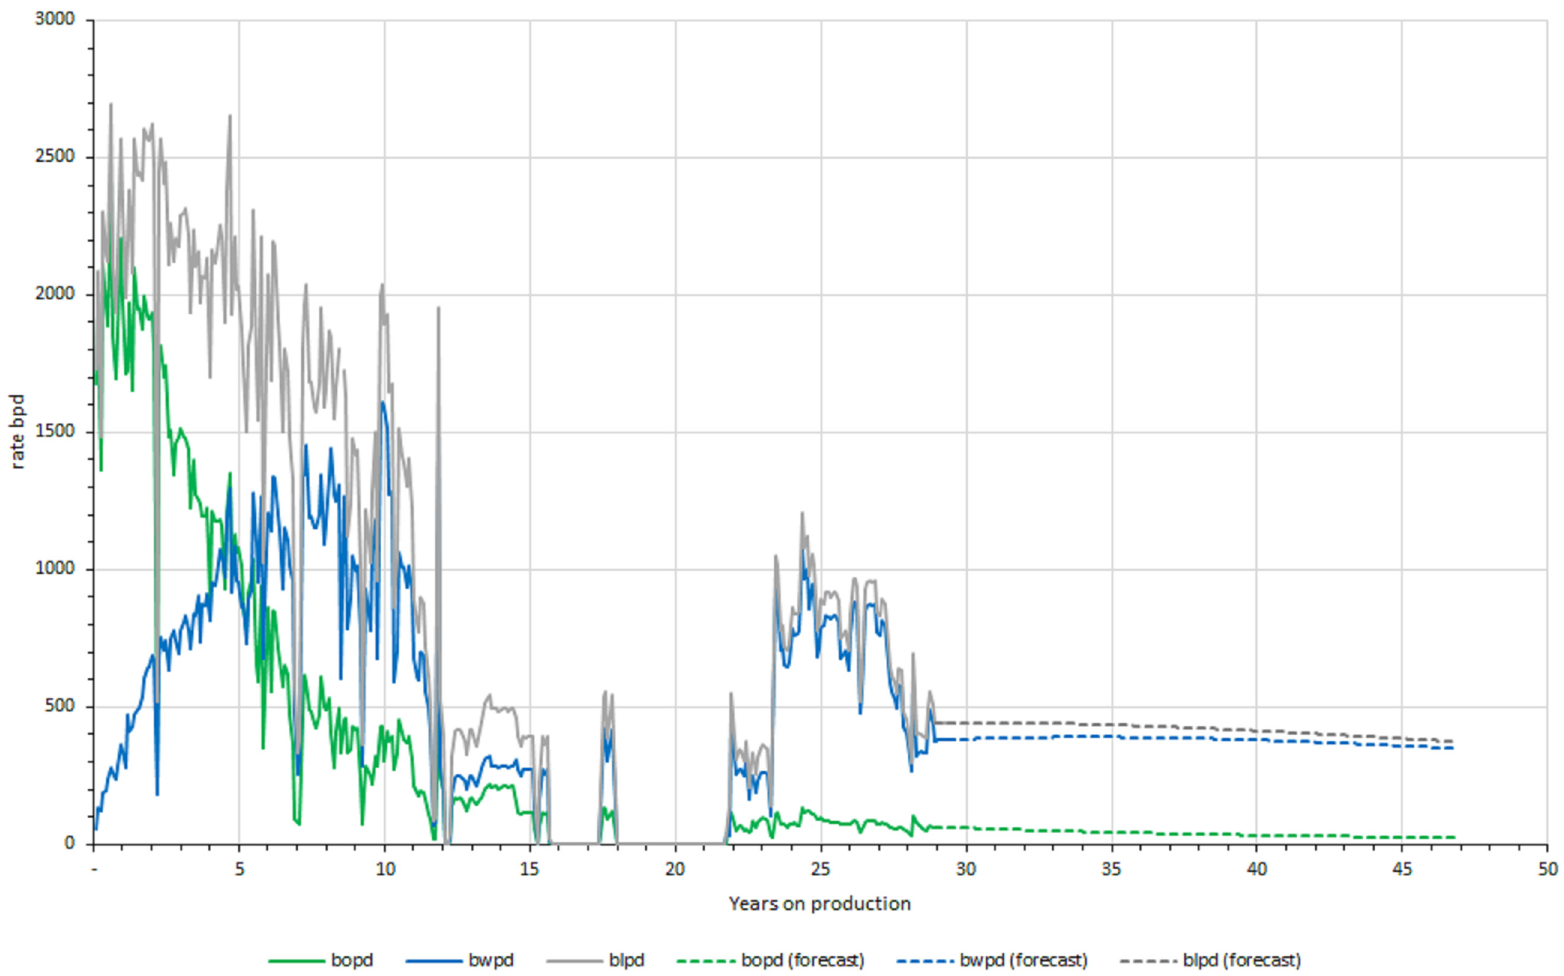
Figure 8. Decline Curve Analysis of the Wareham field until 2037, in the same format as Figure 7 except time is measured from zero on 1 March 1991.